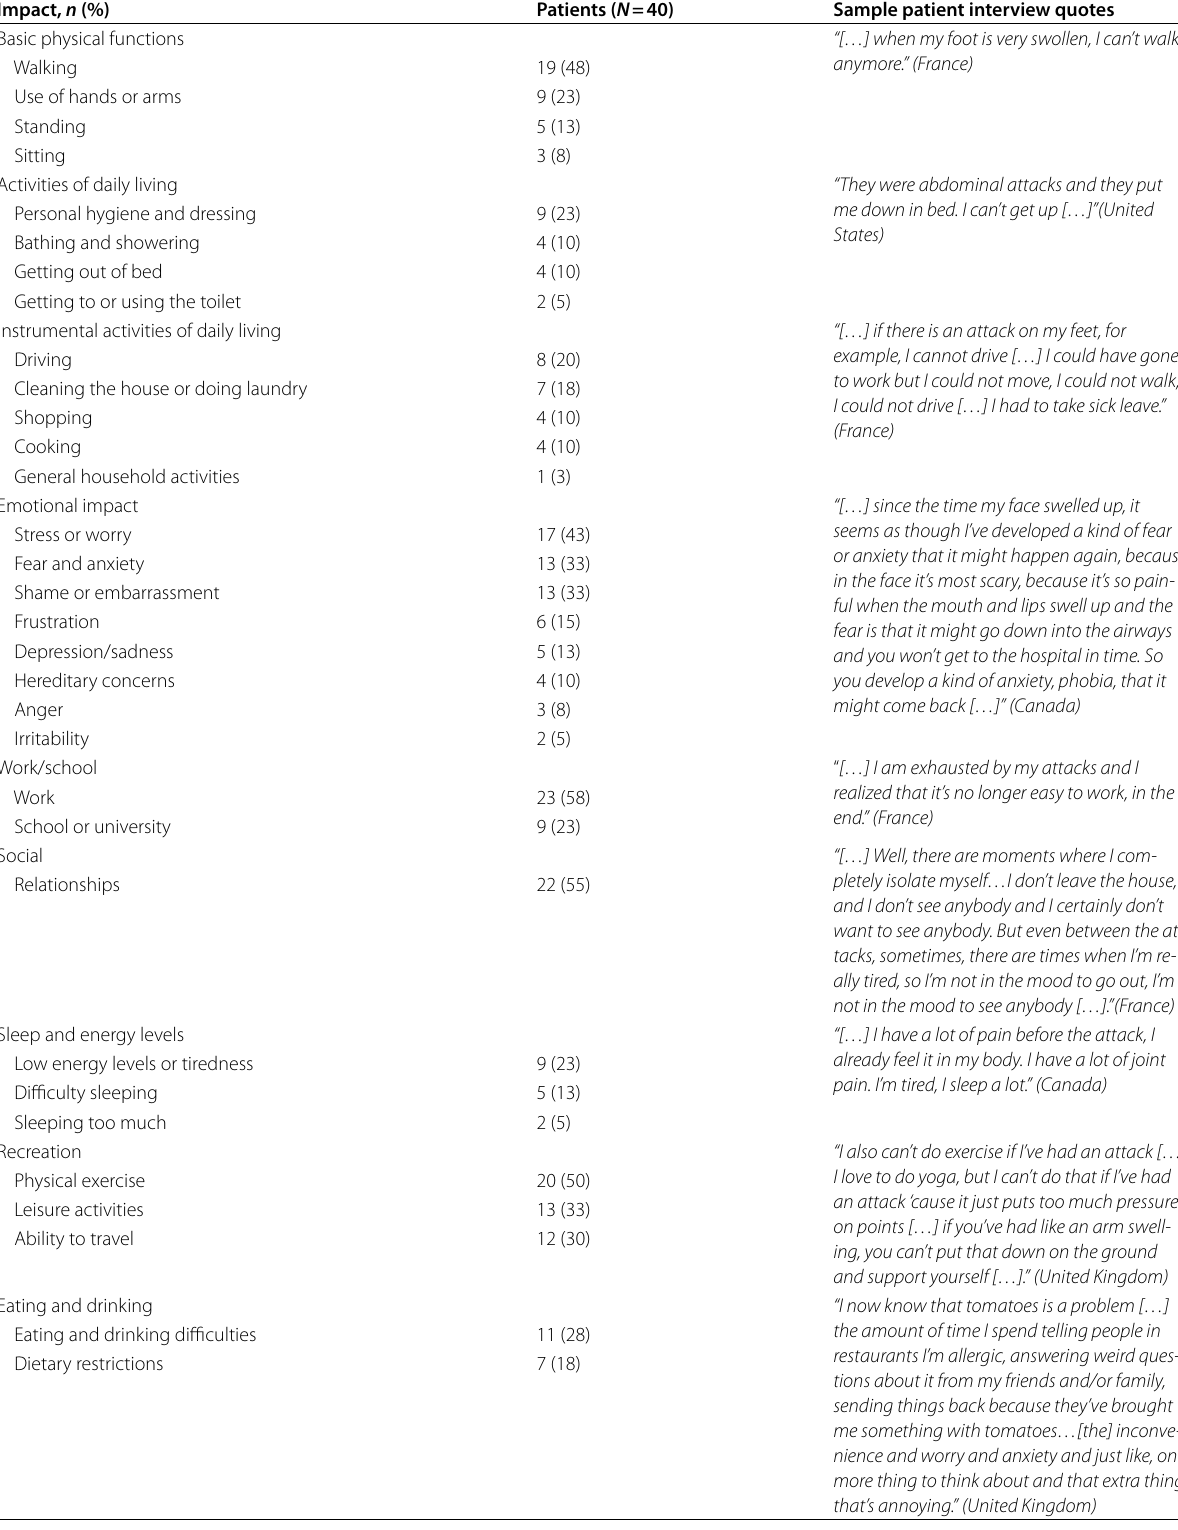
Table 2 Impacts of HAE reported by patients during